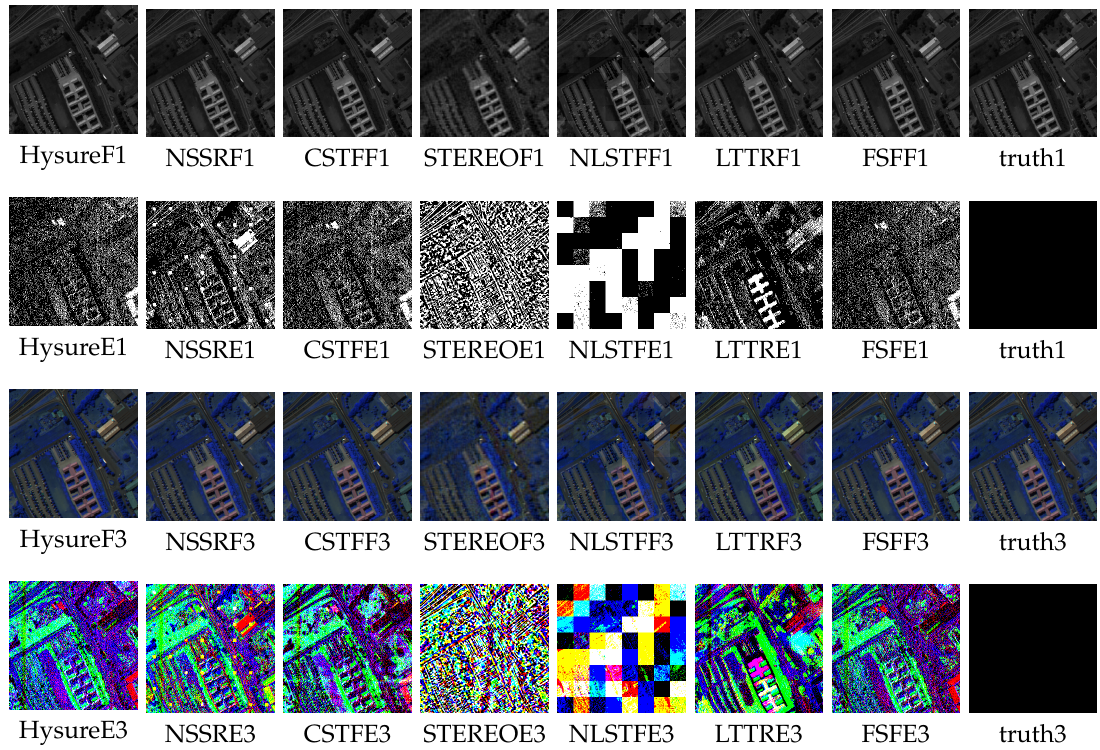
Figure 4. First row: the competing approaches to reconstructed images of Pavia University at 30th band. Second row: the corresponding error images of the 30th band. Third row: the competing approaches to reconstructed images’ false-color images formed by bands 30th, 60th, and 90th. Fourth row: the corresponding error images of the false-color